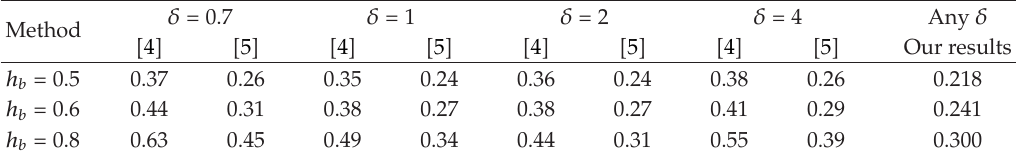
Table 4: Minimum performance level γ